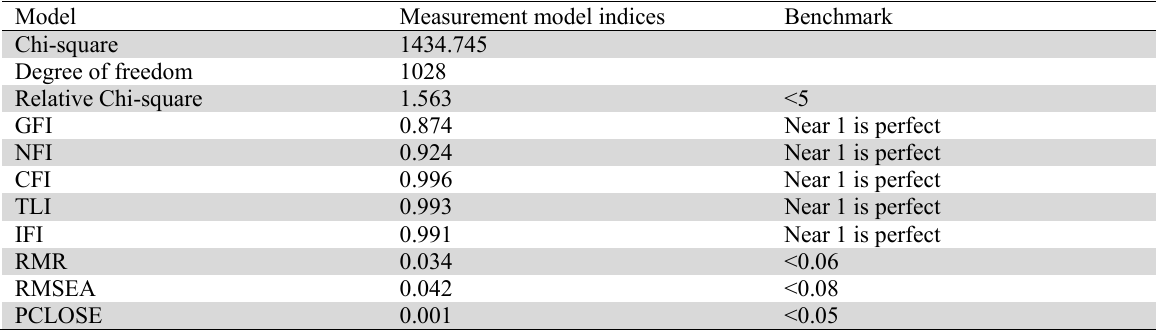
Goodness-of-fit indices Model